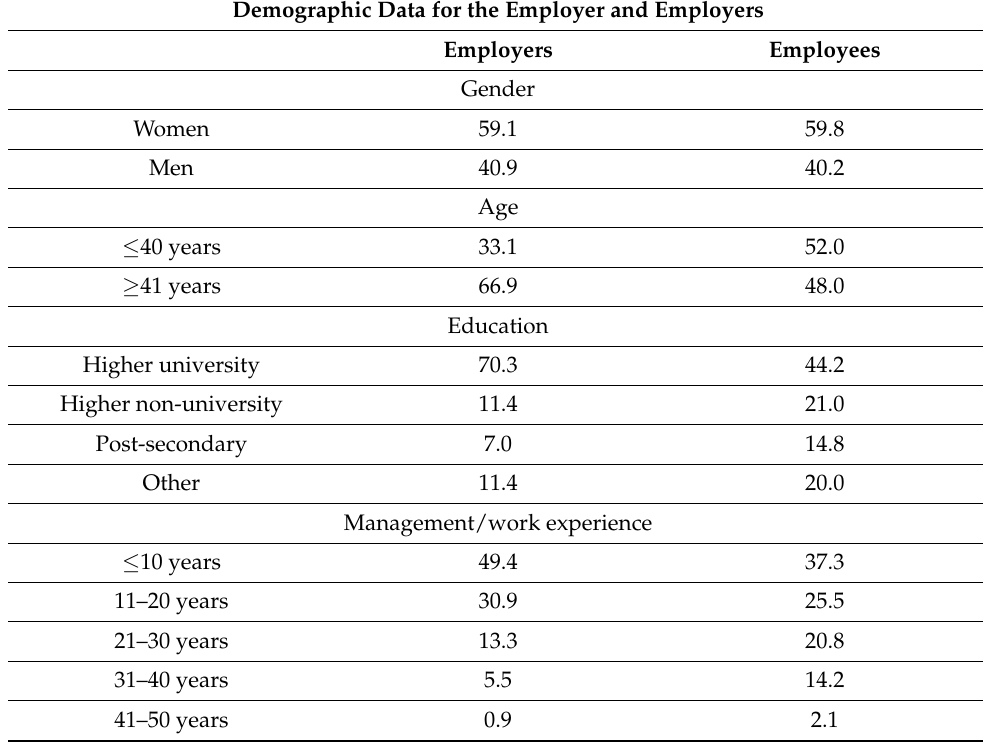
Table 2. Sociodemographic data for the employer and employee groups